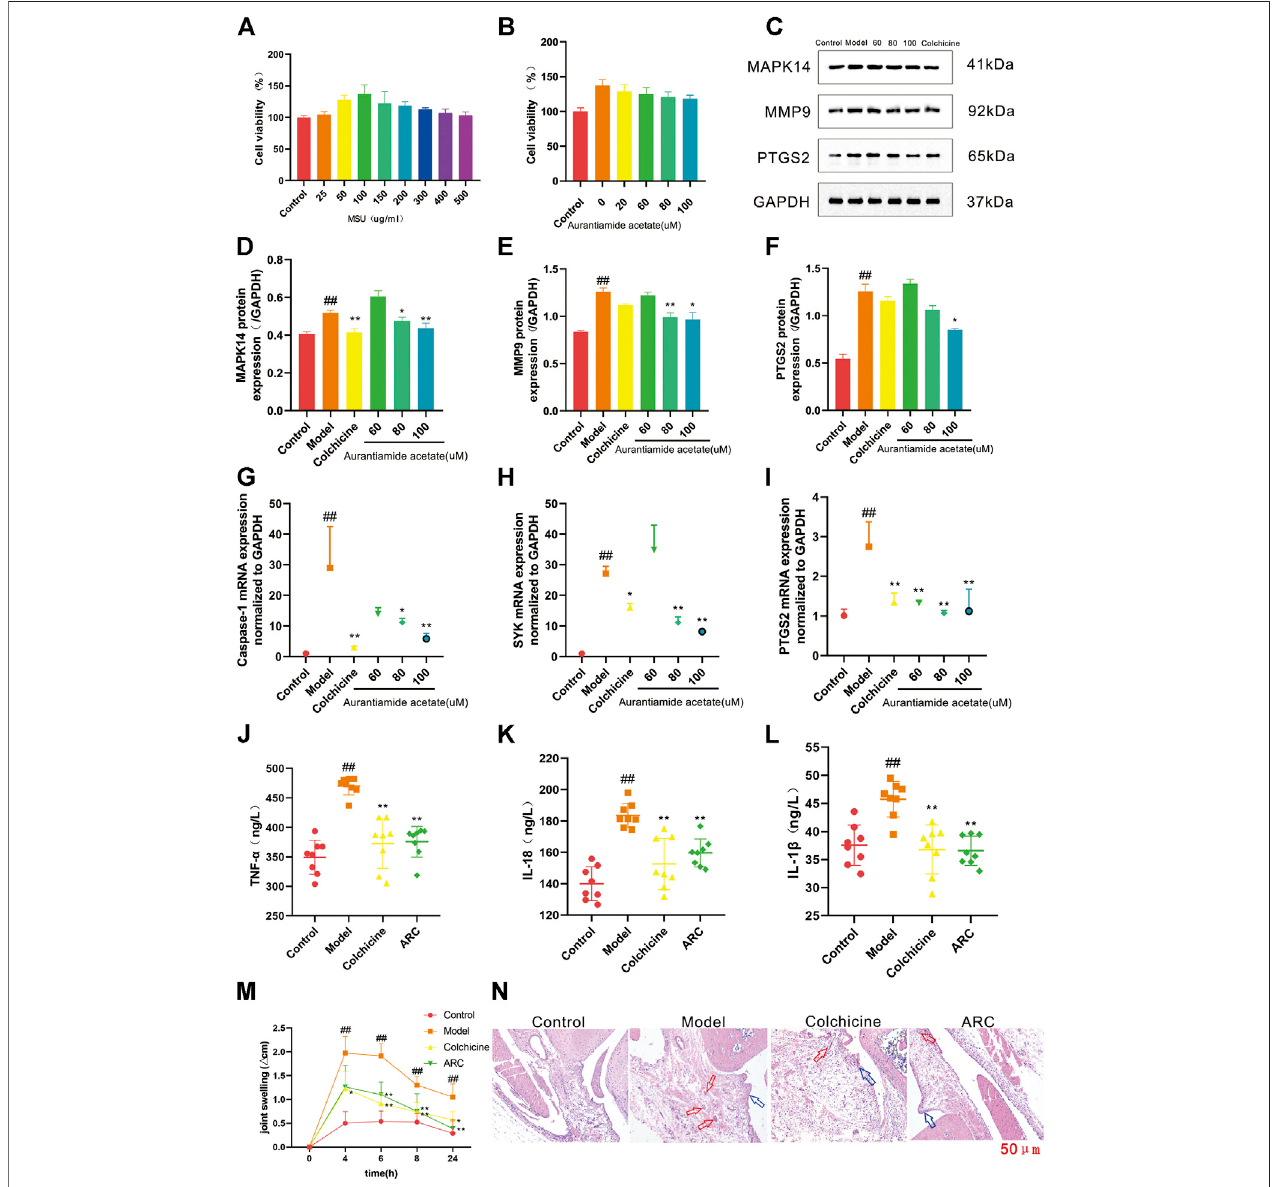
FIGURE 6 | (A) THP-1 cells were exposed to MSU at various concentrations for 24 h. (B) Protective effects of AA on the viability of MSU-induced THP-1 cells. (C) Western blotting. (D) Expression of MAPK14 protein. (E) Expression of MMP9 protein. (F) Expression of PTGS2 protein. (G) Expression of caspase-1 mRNA. (H) ExpressionofSYKmRNA. (I) ExpressionofPTGS2mRNA. (J-L) EffectofARConin fl ammatoryfactorsinratserum. (J) TNF- α . (K) IL-18. (L) IL-1 β . (M) Thekneejoint circumference of rats were determined at 0, 4, 6, 8, 24 h after MSU stimulation, the increment at different time point was calculated. (N) Histopathological